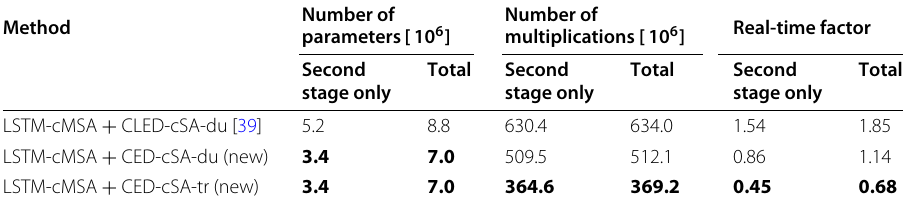
Table 4 Comparison of complexity in terms of number of trainable parameters, multiplications and real-time factor (measured on an Intel Core i5 machine clocked at 3.4 GHz) for our proposed methods and the high-complexity reference pre-published in [39]. Comparisons are given for the second stage, for which the methods differ, and for the total two-stage system